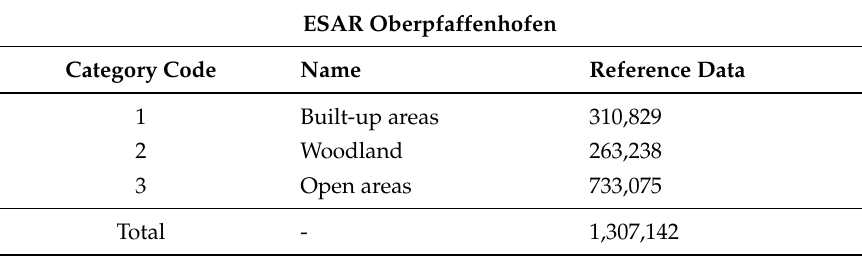
Figure 9. ESAR Oberpfaffenhofen dataset. ( a ) Pauli RGB map. ( b ) Ground truth map. Table 2. Number of pixels in each category for ESAR Oberpfaffenhofen.